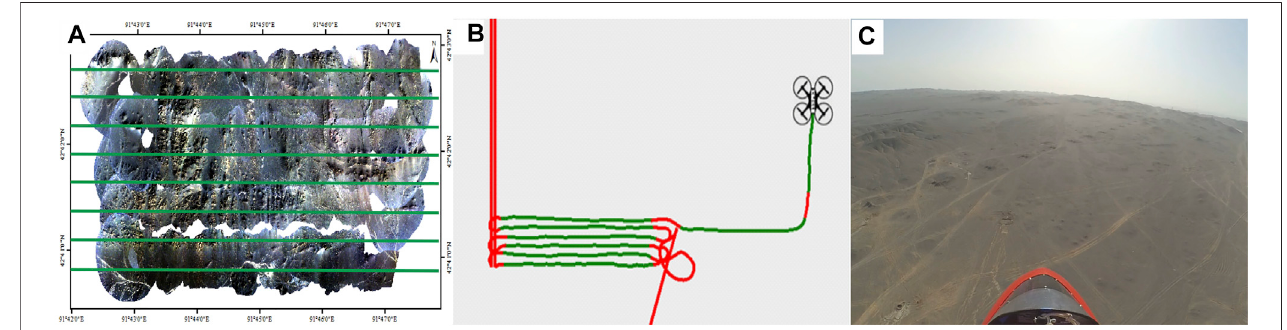
FIGURE 5 | Geometric correction, atmospheric correction, and bad band removal (A) before geometric correction preprocessing, (B) after geometric correction preprocessing, (C) before atmospheric correction and bad band removal preprocessing, and (D) after atmospheric correction and bad band removal preprocessing.